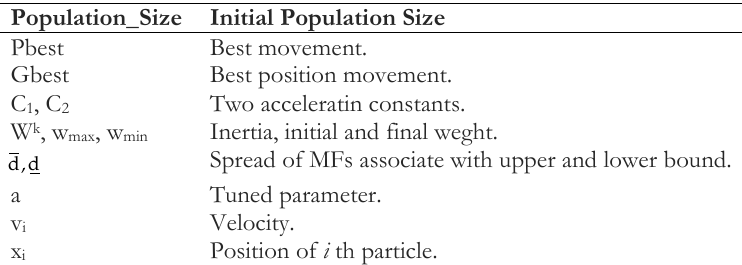
Table 1. The PSO parameters and their